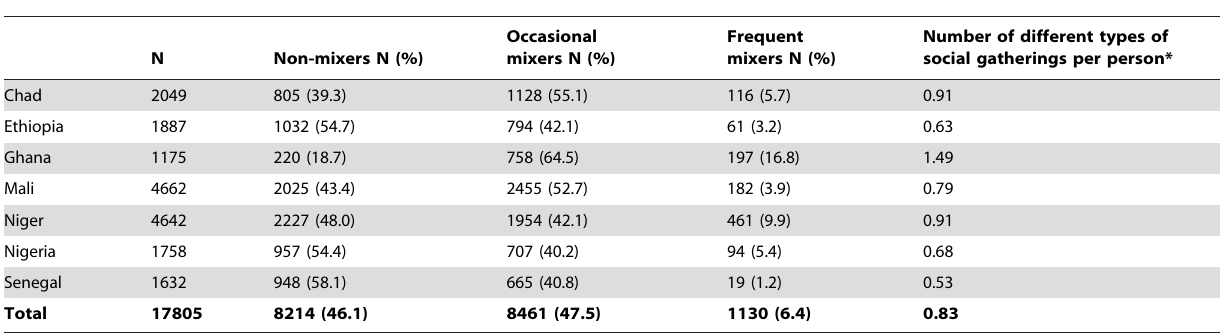
Table 2. Number (%) of individuals’ social mixing patterns by country.